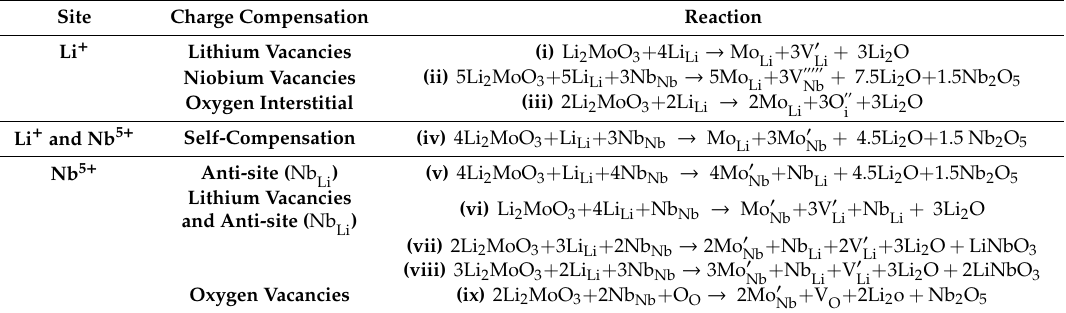
Table 7. Types of defects considered due to M = Mo 4 + incorporation in LiNbO 3